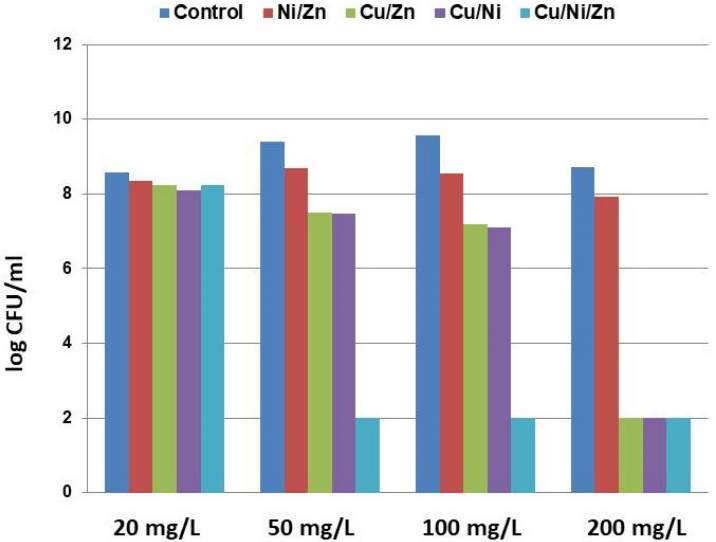
Figure 2. The dose-dependent impact of zinc, copper, and nickel combinations on S. xiamenensis DCB2-1 cell population is presented as log (CFU/mL).